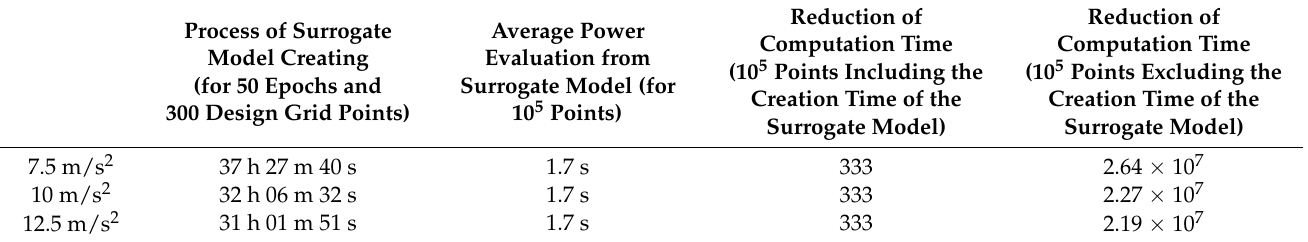
Table 3. Comparison of execution times for surrogate creation and those required for estimation of average output power for three different vibration